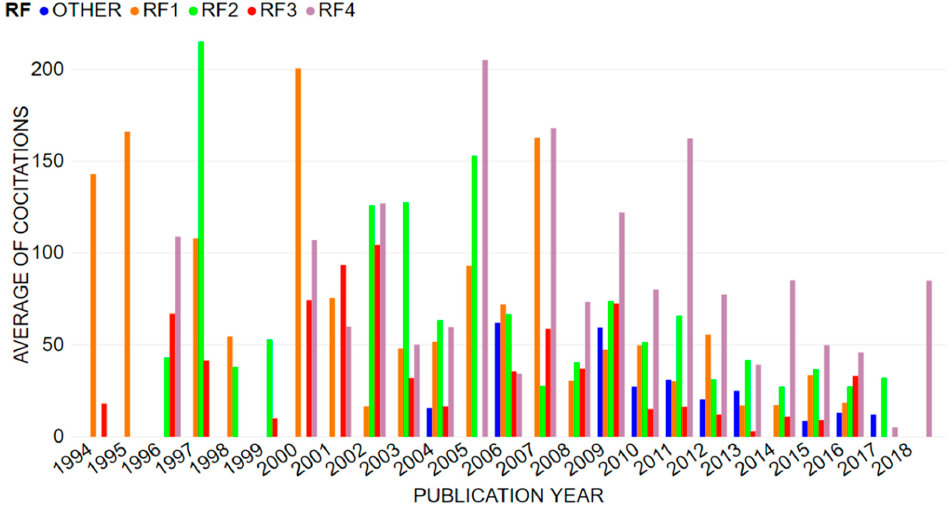
Figure 4. Temporal analysis of RFs, excluding [2].